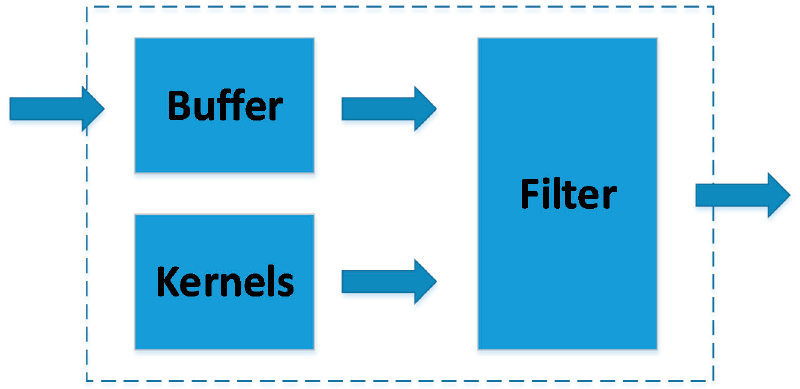
Figure 8. Schematic representation for the architecture of the FilterNxN module.